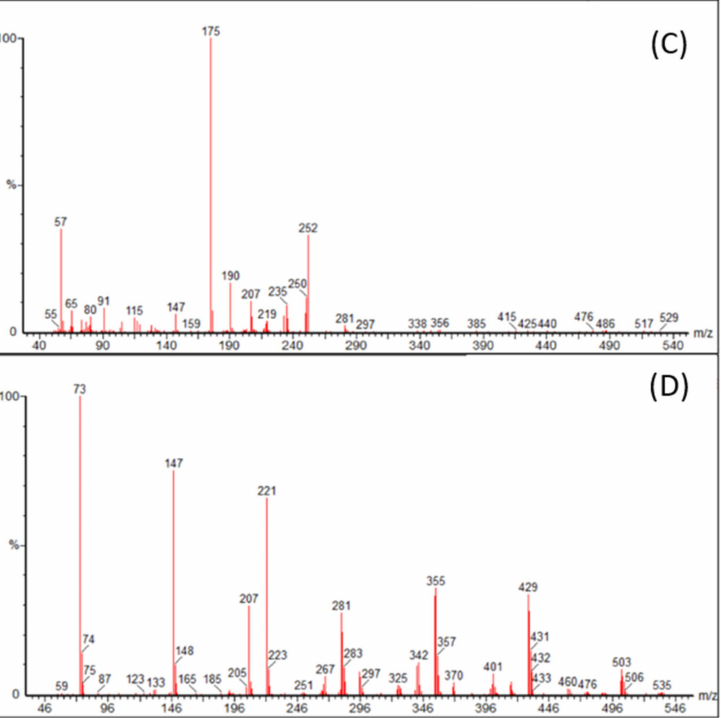
Figure 9. GC-MS analysis of two valves put in contact with absolute ethanol with ( A ) the total scan and ( B – D ) the respective m/z of the peaks 1. 2. and 3 isolated in the total scan.